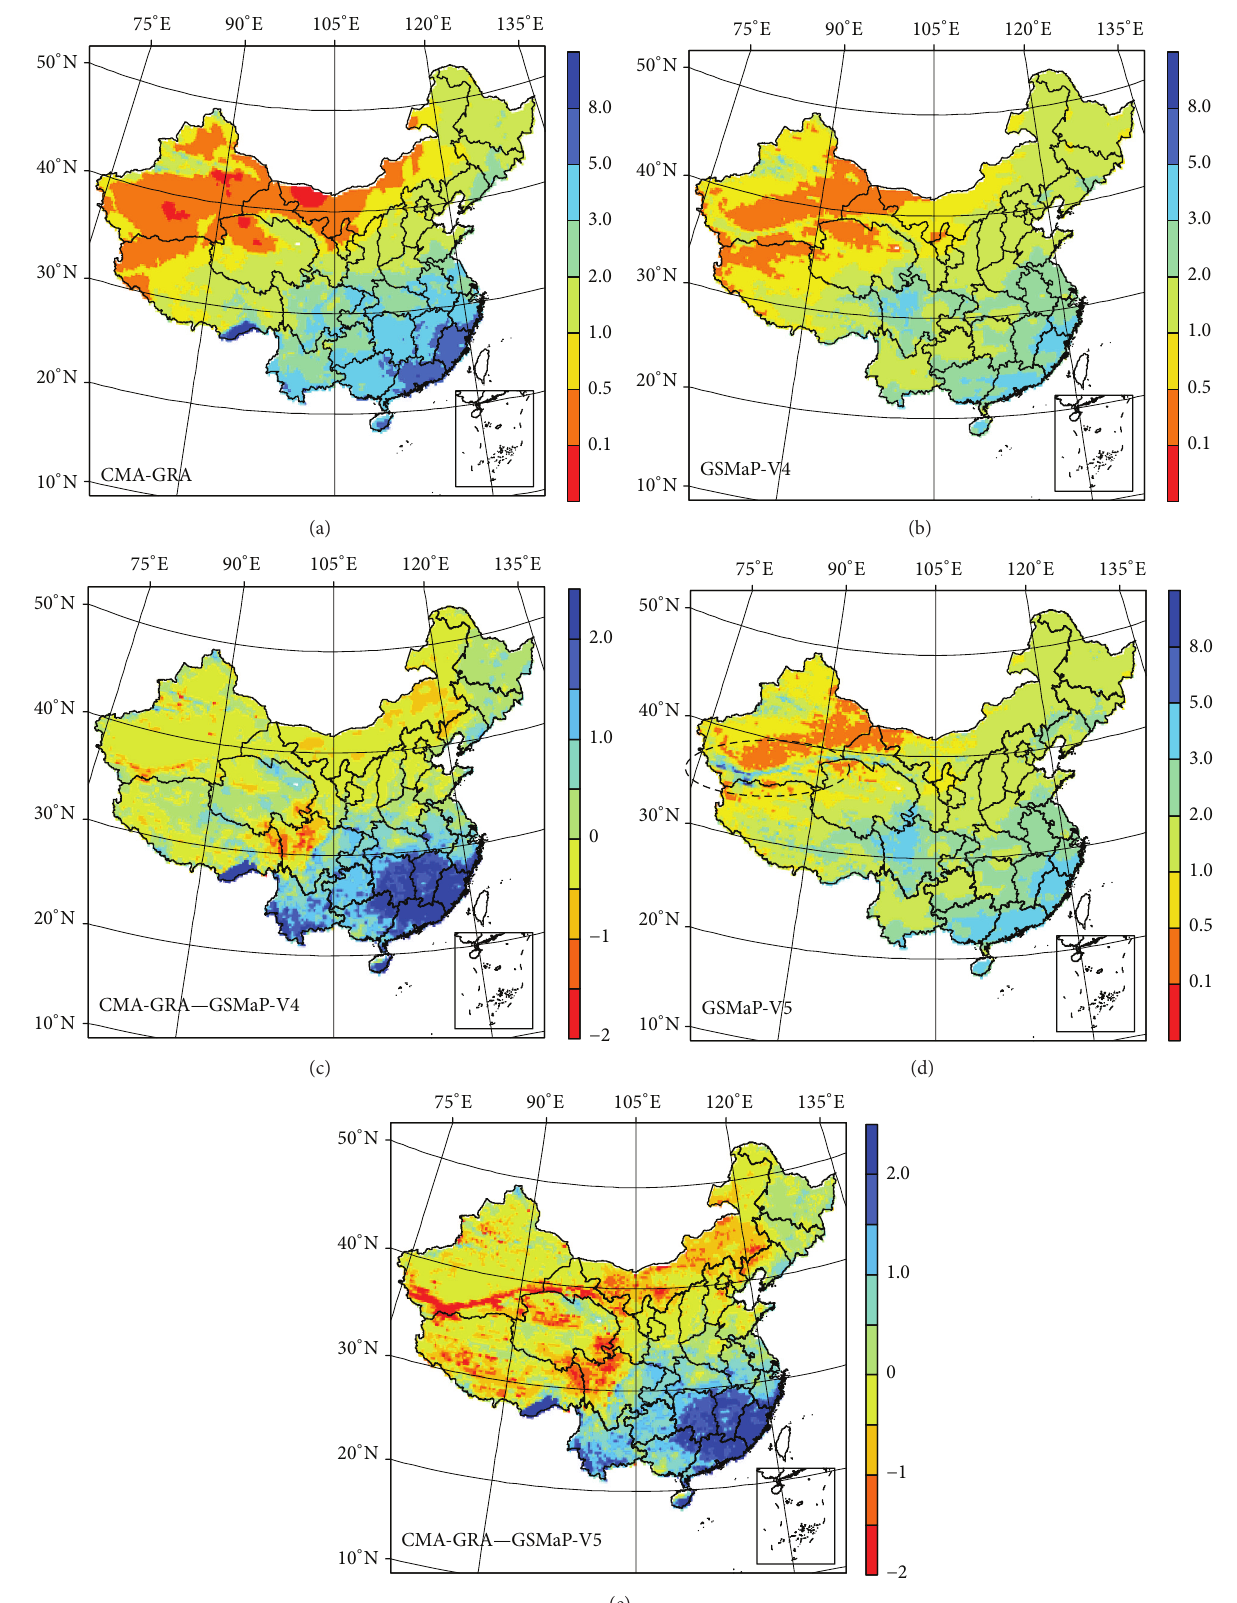
Figure 3: Distribution of daily mean precipitation over the Chinese Mainland from 2003 to 2006. Units are mm/day. (a) CMA-GRA, (b) GSMaP-V4, (c) differences between CMA-GRA and GSMaP-V4, (d) GSMaP-V5, and (e) differences between CMA-GRA and